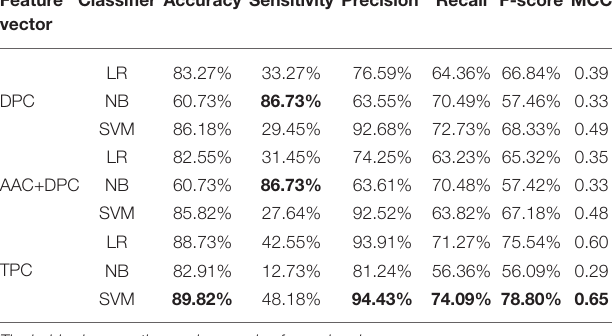
TABLE 1 | Cross-validation performances of AAC with different classifiers on PM275. Classifier Accuracy Sensitivity Precision Recall